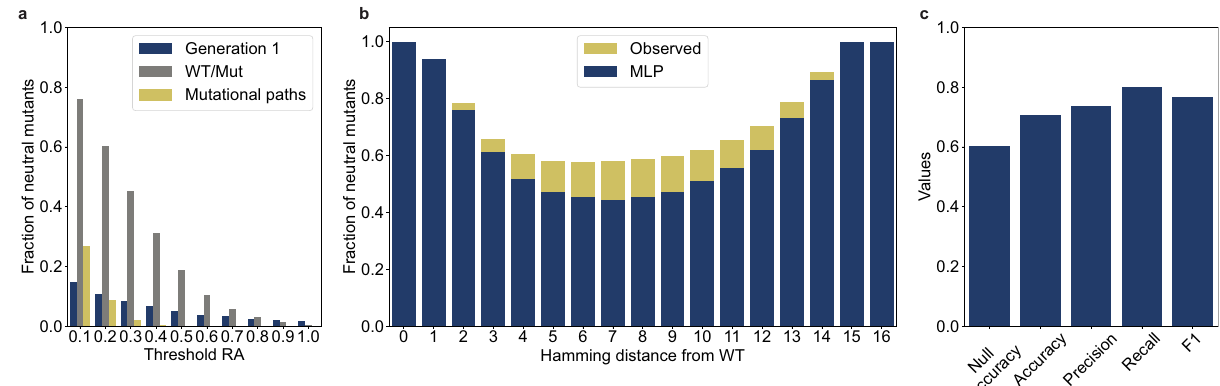
Fig. 5 | Combinatorial space between F1*U and F1*U m contains many neutral mutants predictable by deep learning. a Fraction of neutral mutants in the combinatorial library between the F1*U and F1*U m (WT/Mut) and in generation 1 according to different RAthresholdsofneutrality. Atotalof 10 6 unique mutational pathswererandomlysampledthatcouldtransformtheWTsequencetoF1*U m in16 directmutationalsteps.Pathswereconsideredneutralifnoneofthestepsresulted